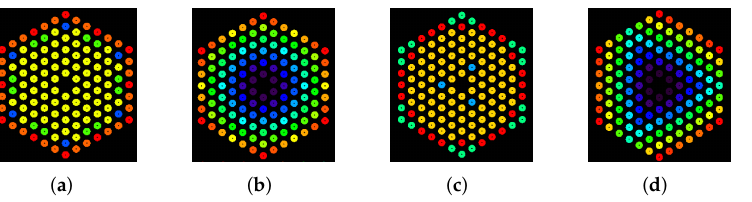
Figure 3. ( a ) Fresh fuel assembly of type Gd47 containing burnable Gd poison (blue pins) and ( b ) the same assembly after the burnup calculation. ( c ) Fresh fuel assembly of type Gd2n containing burnable Gd poison (blue pins) and ( d ) the same assembly after the burnup calculation. Different colours indicate different material